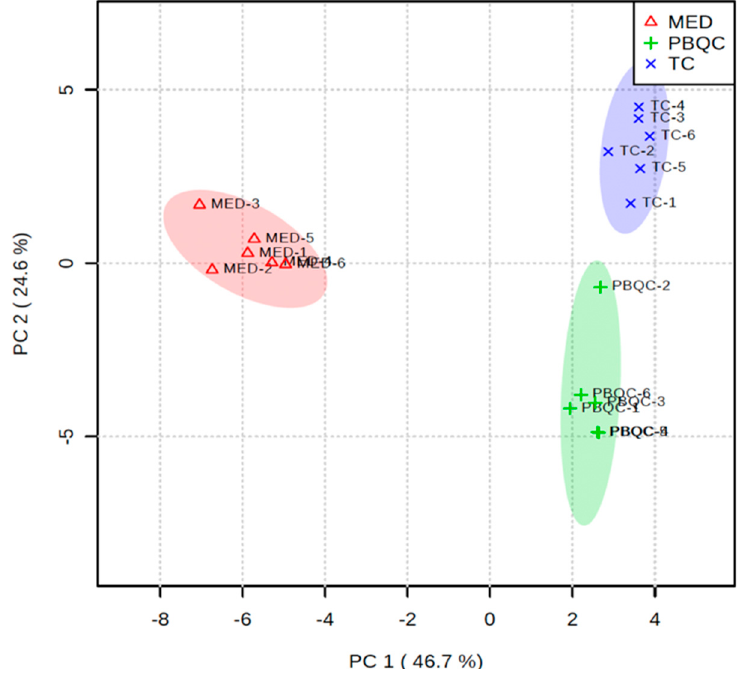
Figure 2. Principal component analysis of polar metabolites of Toxocara canis excretory-secretory products (ESPs) showing clear separation from the media component. MED—culture media samples,